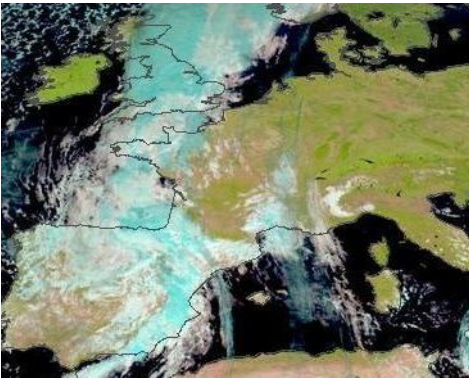
Figure 10. Cloud cover for the 14 October 2018 at 11 UTC, SEVIRI